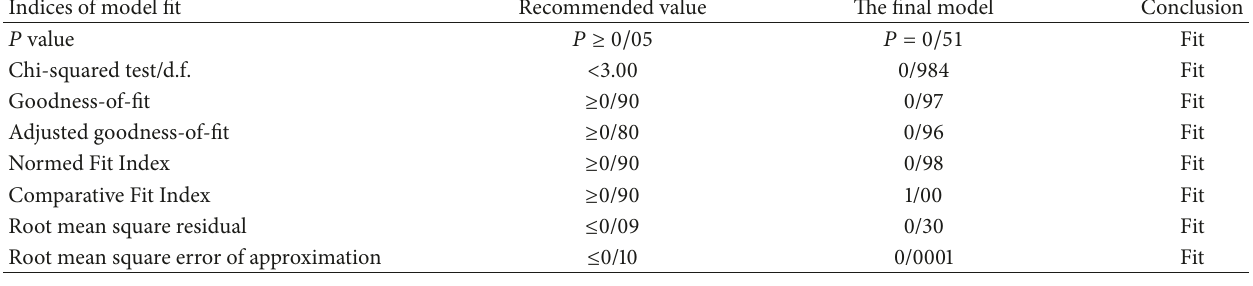
Table 3: Indices and the recommended values of model fit for the structural model.